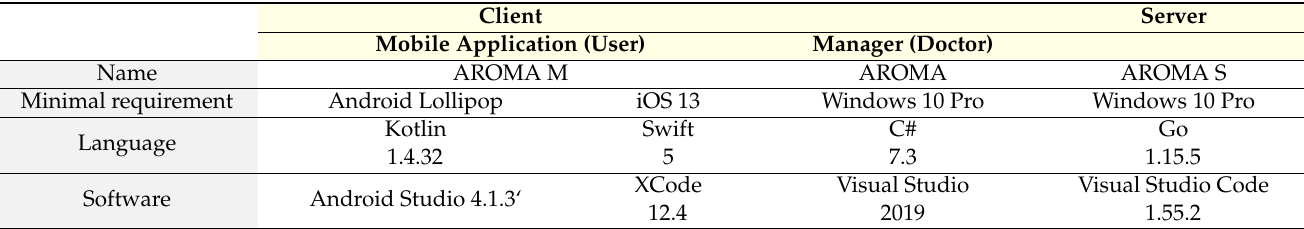
Table 1. Development environment and minimal requirement.